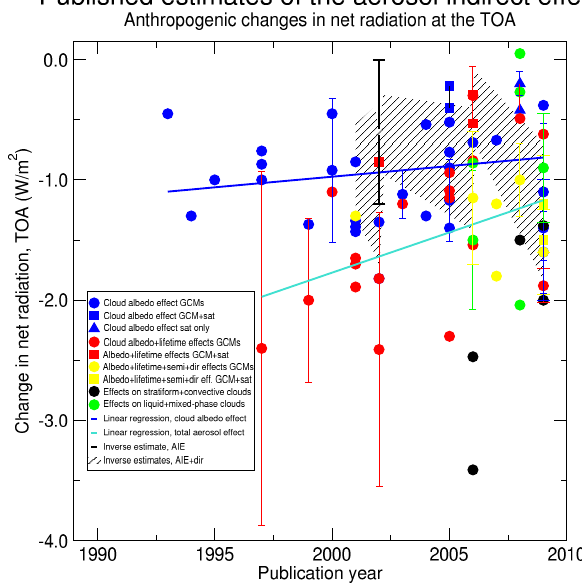
Fig. 1. Model, satellite and inverse estimates of the aerosol indirect effects over the last two decades. For each method or effect considered, each symbol represents one published estimate (one paper one vote). Blue represents estimates of the cloud albedo effect from GCMs (dots), GCMs combined with satellite measurements (squares) and satellite estimates only (triangles). Red represents estimates of both the cloud albedo and cloud lifetime effect from GCMs (dots) and GCMs combined with satellite estimates (squares). The yellow dots represent estimates of the combined cloud albedo, lifetime, direct and semi-direct effects. Black dots represent the aerosol effects on stratiform and convective clouds and green dots represent estimates of aerosol effects on liquid and mixed-phase clouds. The black stippled area refers to inverse estimates. In case of multiple estimates per paper, the vertical bars denote the standard deviation. See appendix for the individual papers, from which the estimates are